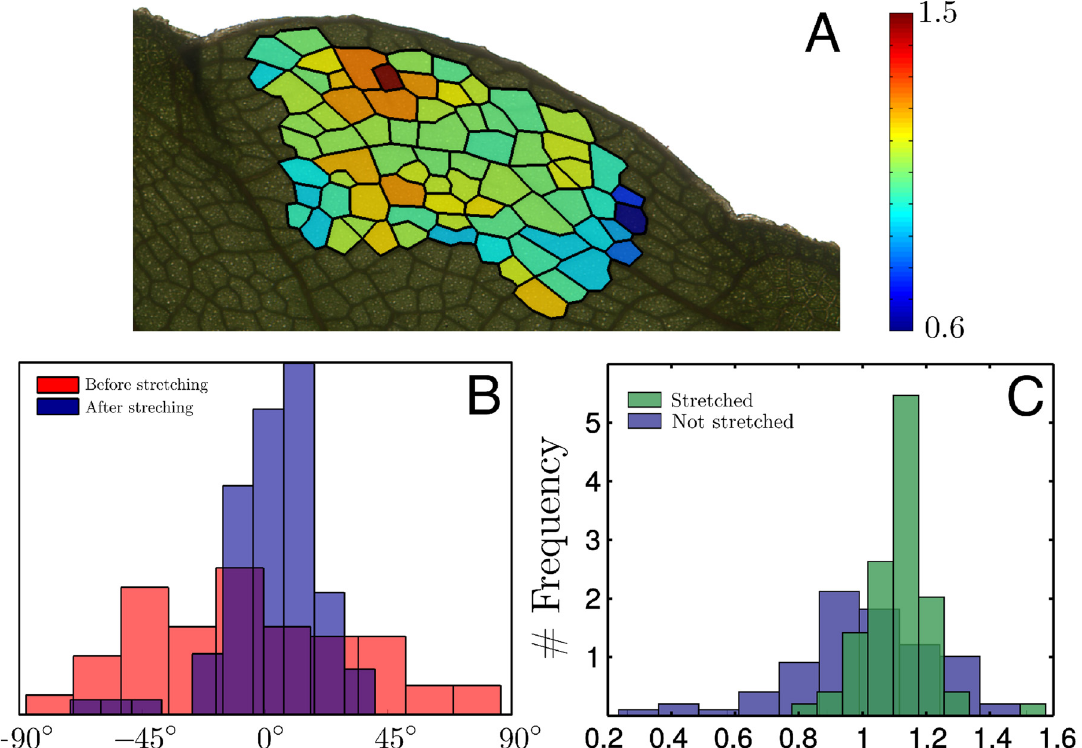
Fig 6. Veins in experiments undergo non-affine deformations. (A) Colormap of the non-affinity index q of each areole, after 15 days of external stretching; in the case of an affine deformation q would be equal to one for all areoles; q > 1 (resp. q < 1) means that the areole grew more (resp. less) than its neighbors. (B) Histogram of the orientation of veins before and after stretching showing that veins reorient in the stretching direction. (C) Histogram of q in the stretched and unstretched